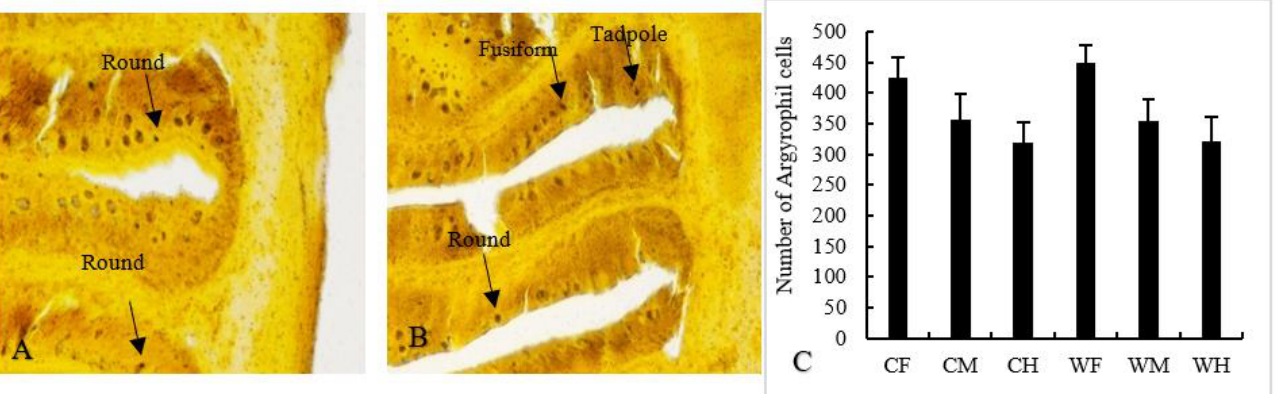
Figure 4. Distribution ( A , B ) and the number ( C ) of argyrophil cells in wild ( A ) and cultured ( B ) Hemibarbus maculatus. Three types of argyrophil cells were found—fusiform, round and tadpole— and the number of argyrophil cells in foregut was generally higher. Note: n = 30, the data were misrepresented by average ± standard deviation. (Longguikai, bar = 50 µ m) Note: n = 30, the data were misrepresented by average ± standard